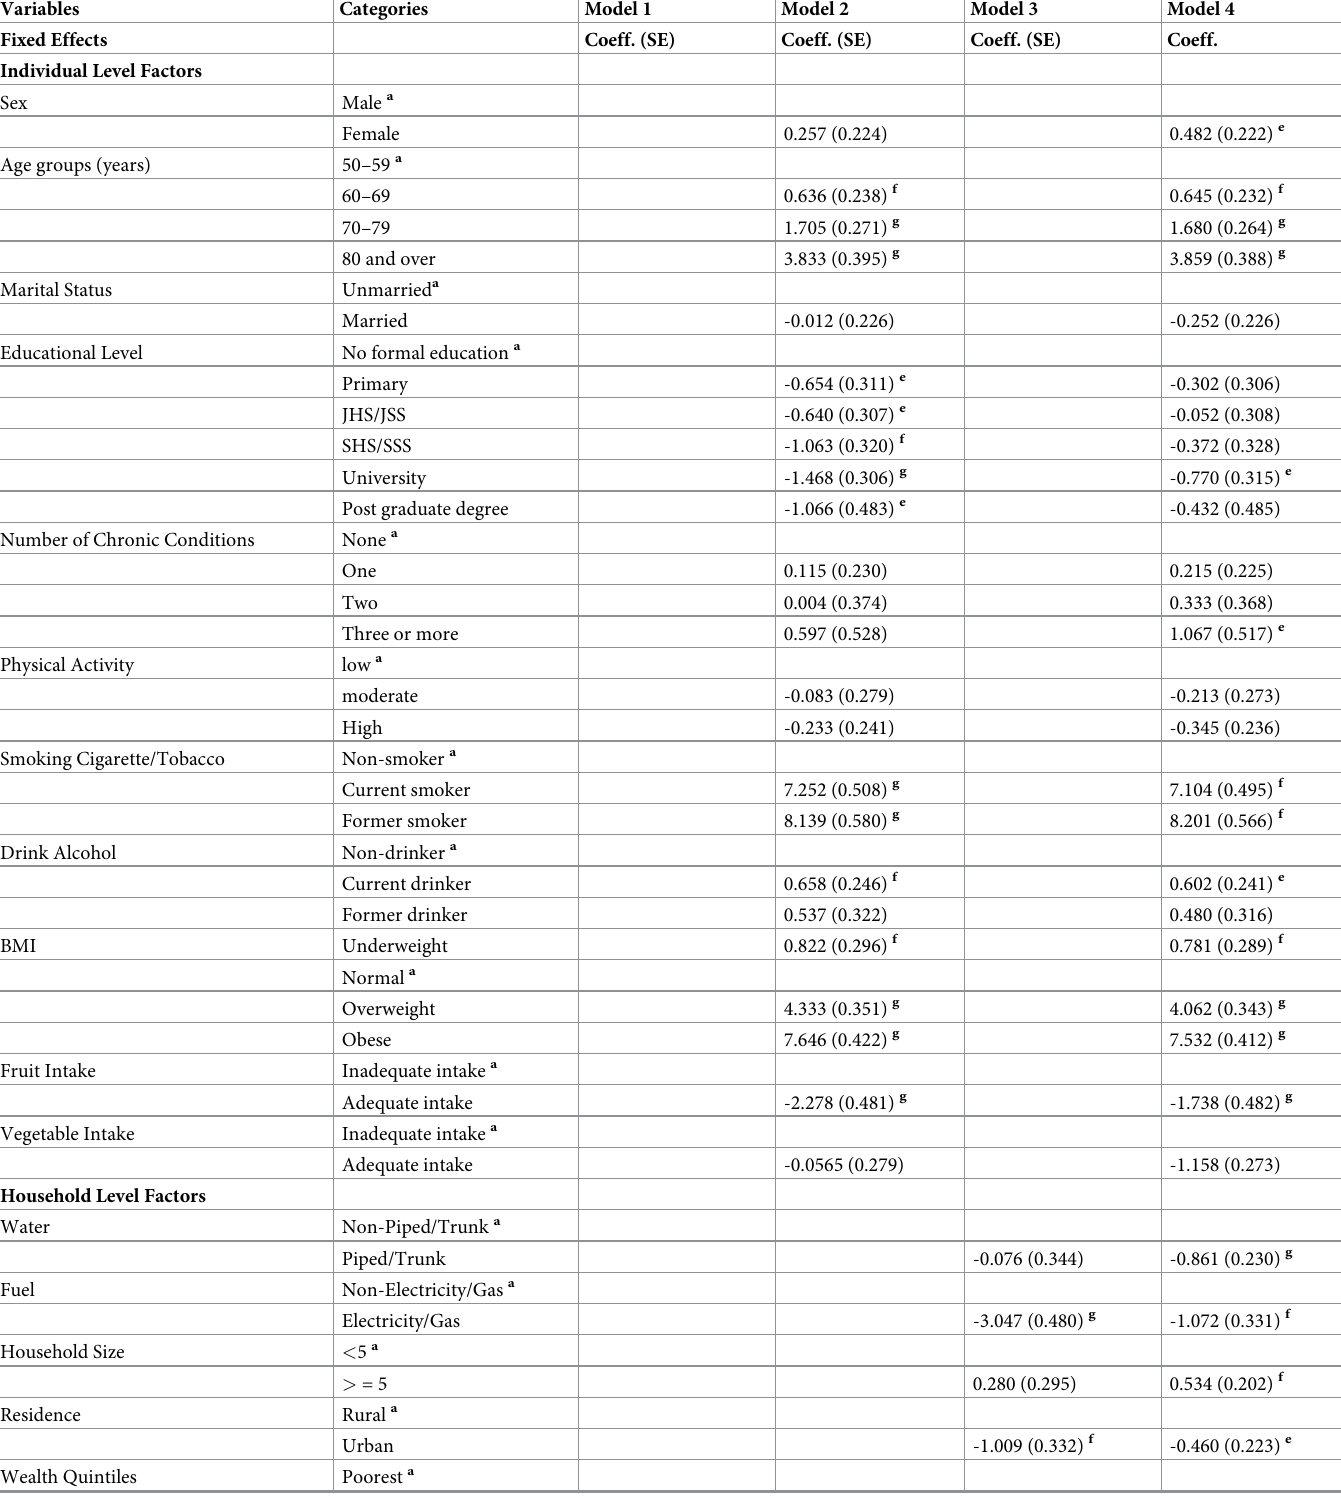
Table 2. Regression results for two-level models of WHODAS II